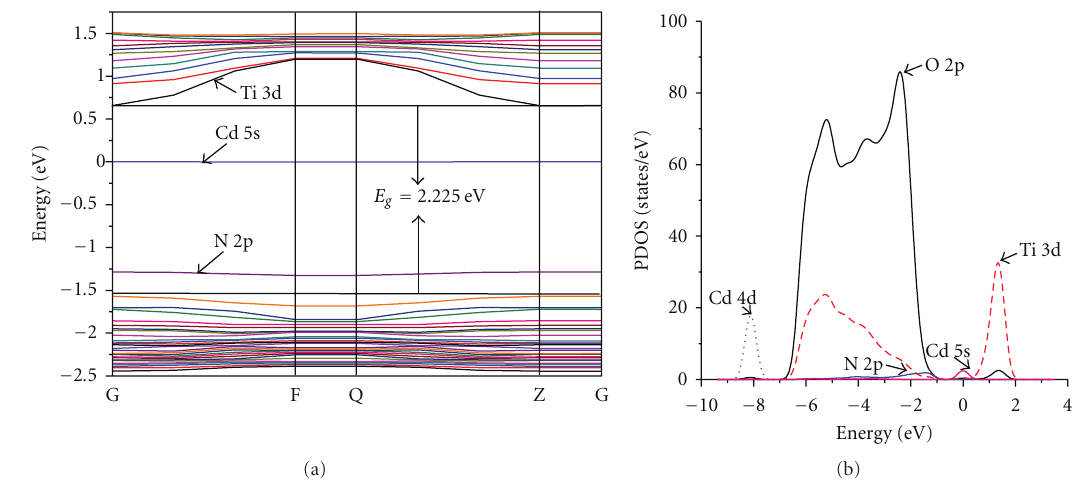
Figure 8: Ti 32 CdO 63 N: (a) band structure, (b) partial density of